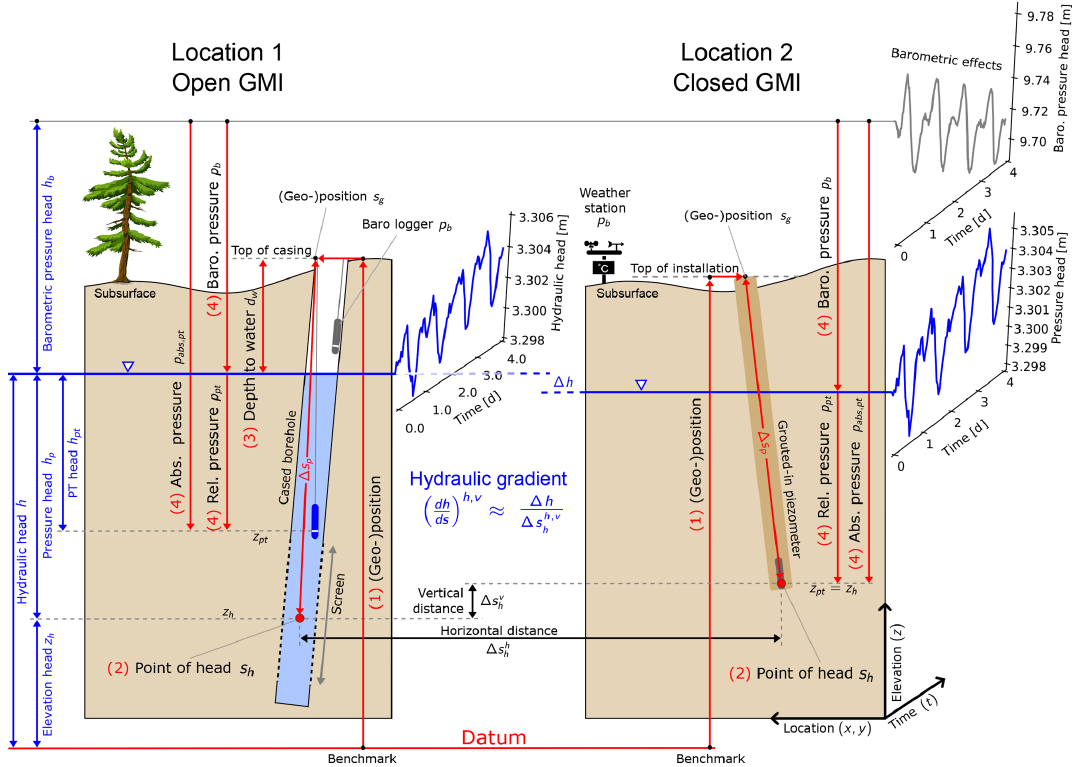
Figure 1. Overview of the four individual measurements (enumerated as steps and marked in red) required to calculate time series of hydraulic head (one location) and gradient (two locations) using two different types of groundwater monitoring infrastructure (GMI). Location 1 shows a cased borehole that is open to the atmosphere (open GMI), whereas Location 2 illustrates a fully grouted-in piezometer (closed GMI). The boreholes are drawn at an angle to highlight the importance of errors caused by inclination during construction of the